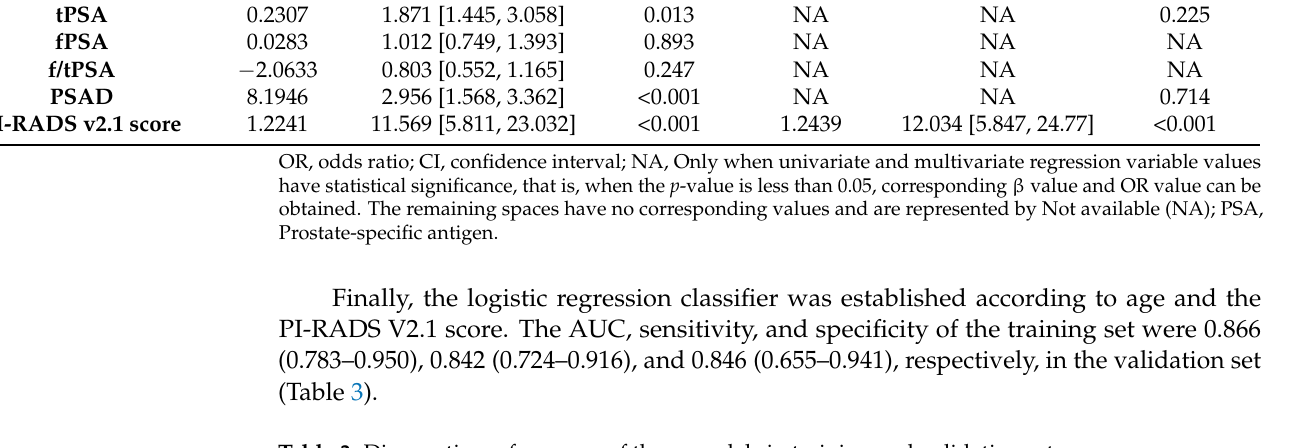
Table 3. Diagnostic performance of three models in training and validation